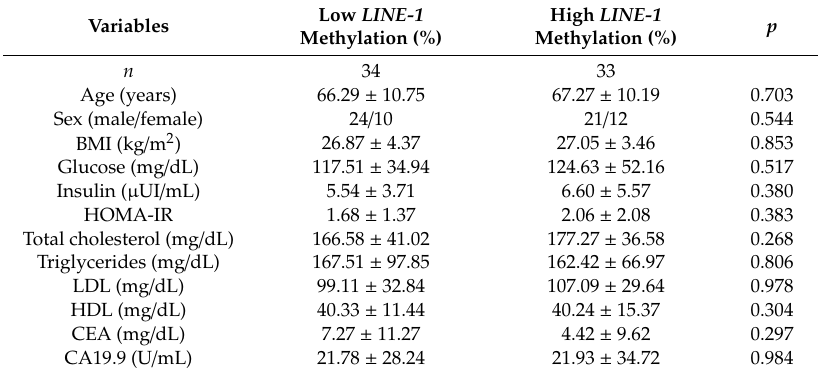
Table 1. Baseline characteristics of the epidemiological and clinical variables of the population